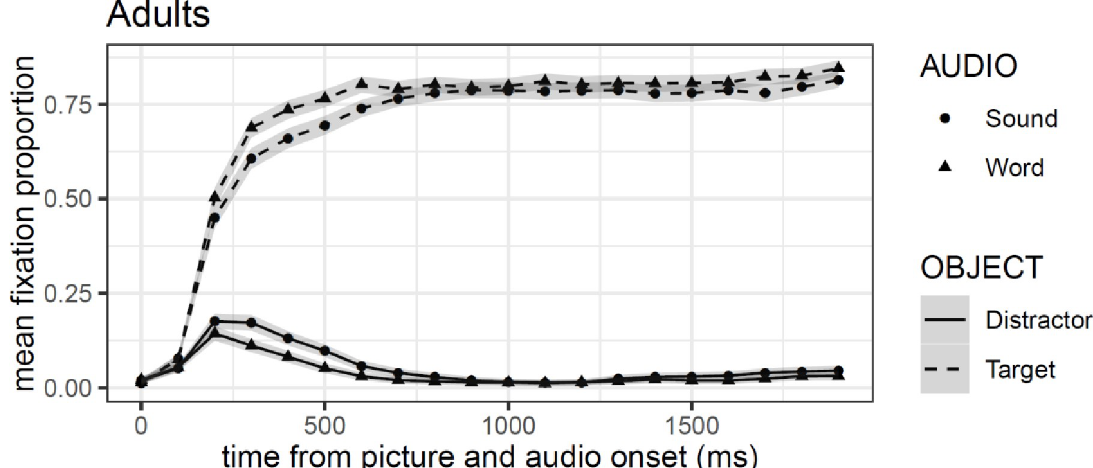
Fig 3. Mean fixation proportion (aggregated by participants) as a function of object in the visual context and type of auditory stimulus in Experiment 1B. Shaded areas around lines represented 95% confidence intervals adjusted for within-subject designs and multiple time